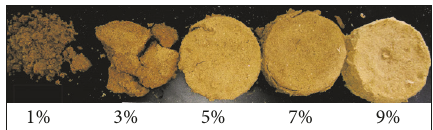
Figure 11: Photos of reinforcement layers taken from the specimens with curing time of 24 h after single-hole permeability tests.